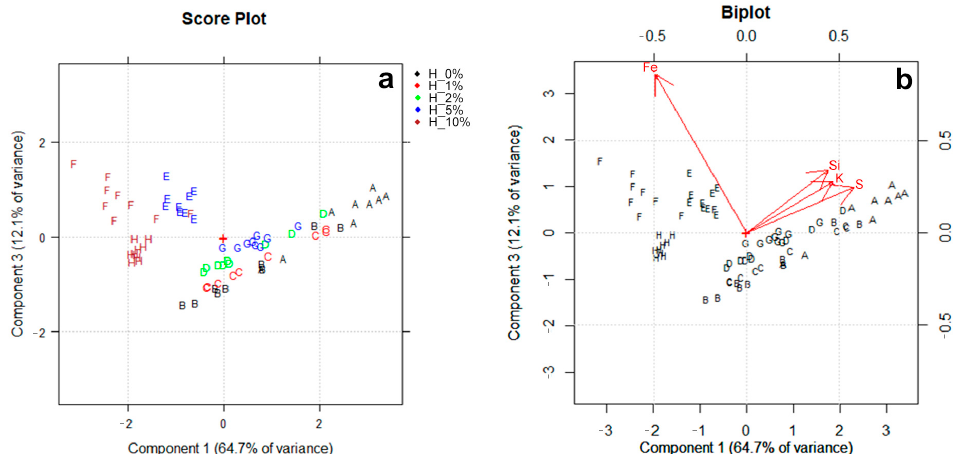
Figure 11. Results of the principal component analysis (PCA) performed on the XRF spectral dataset: PC1 versus PC3 scatter score plot ( a ) and the related biplot ( b ). Letters in ( a , b ) indicate the mock-ups under investigation; colors in ( a ) highlight different hematite concentrations in the paint layer as reported in the legend (i.e., H_0%, H_1%, H_2%, H_5%, H_10%, where the letter H stands for hematite). Table 2. Summary of the potential and limits of different non-invasive techniques applied to the study of the dried mock- ups ( t 0 ) investigated in this work.